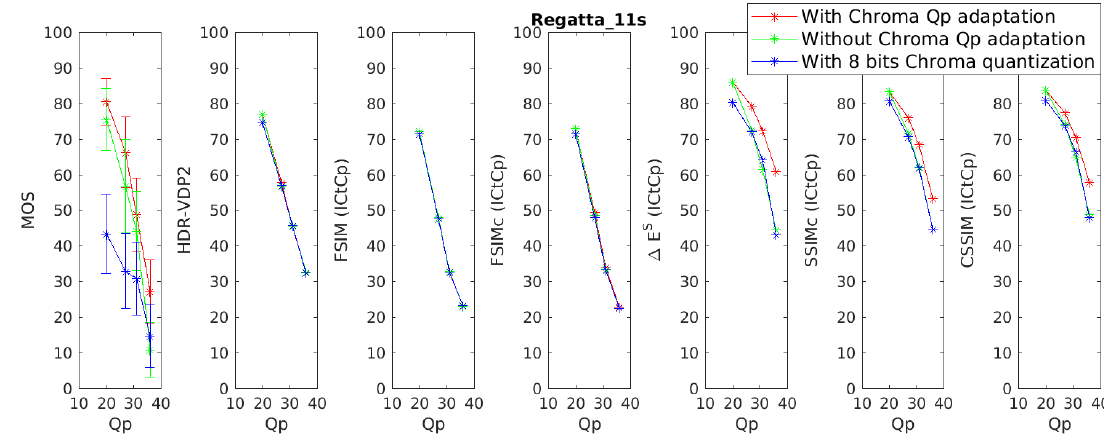
Figure A10. Subjective and objective scores for the image Regatta_11s